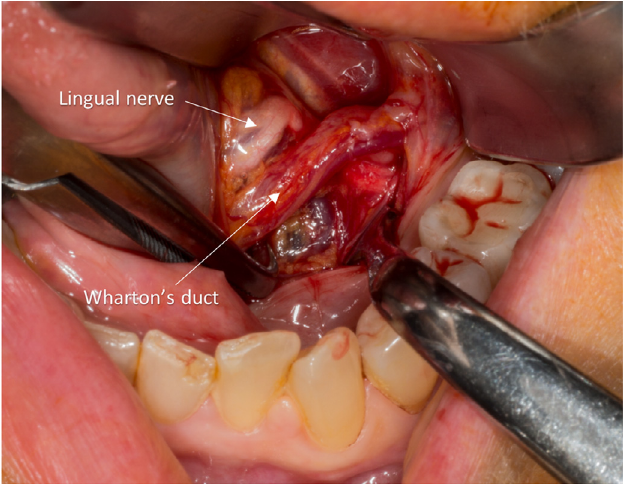
Fig. 1. The submandibular ’ s duct crosses its path over the lingual nerve next to the fi rst mandibular molar.